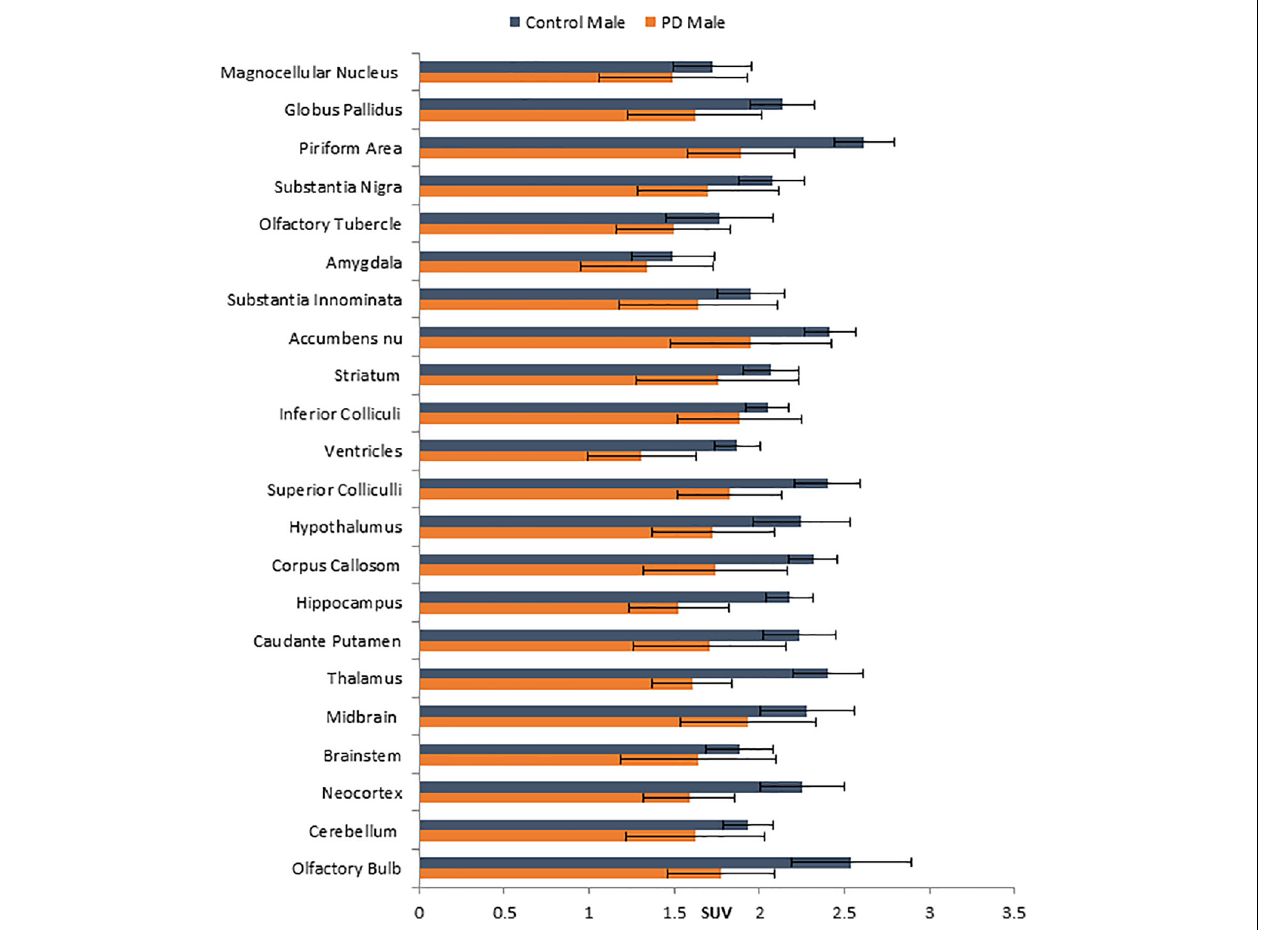
FIGURE 3 | Comparison of average [ 18 F]FDG standard uptake values (SUV) with standard deviation of male non-carrier mice with A53T PD male mice across different brain regions shown in Figure 1K